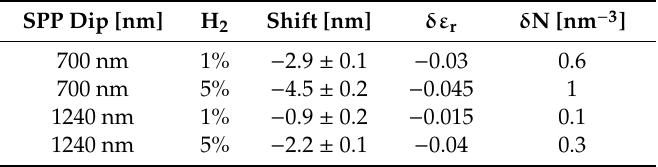
Figure 5. Sensing test at 300 °C towards 5% H 2 for plasmonic grating coated with TiO 2 . Table 1. Plasmonic grating sensor: observed resonance shifts for the two monitored SPP dips in 1% and 5% H 2 atmosphere, with corresponding permittivity variation ( δε ) according to simulations and charge carrier injection in the conduction band of TiO 2 ( δ N) estimated with Equation (4).